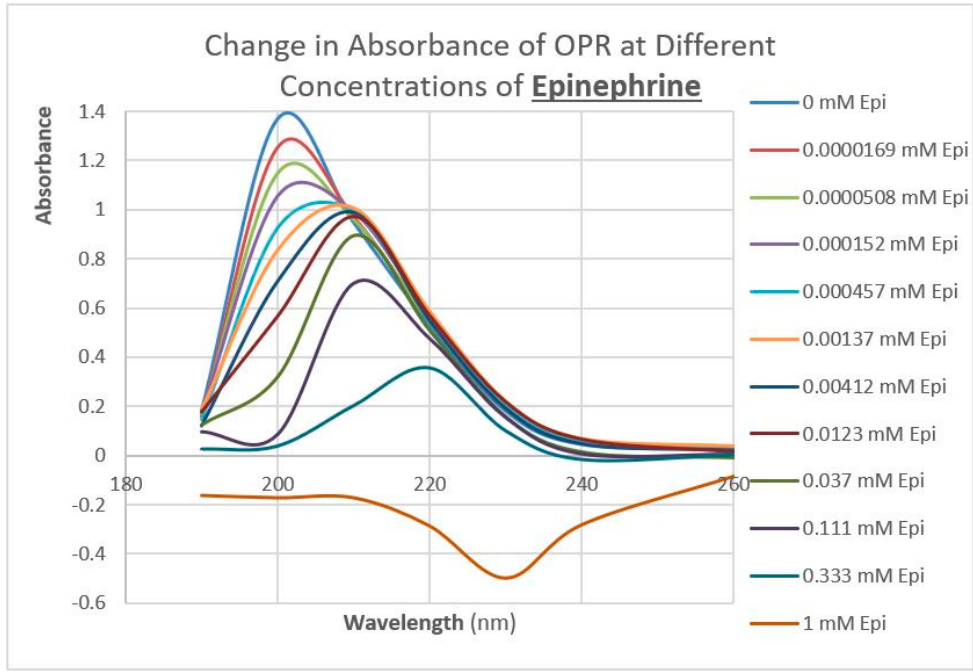
Figure 8. Effect of serial additions of epinephrine at increasing concentrations on the UV spectrum of intact mu opioid receptors (muOPRs). Compare with Figure 7.